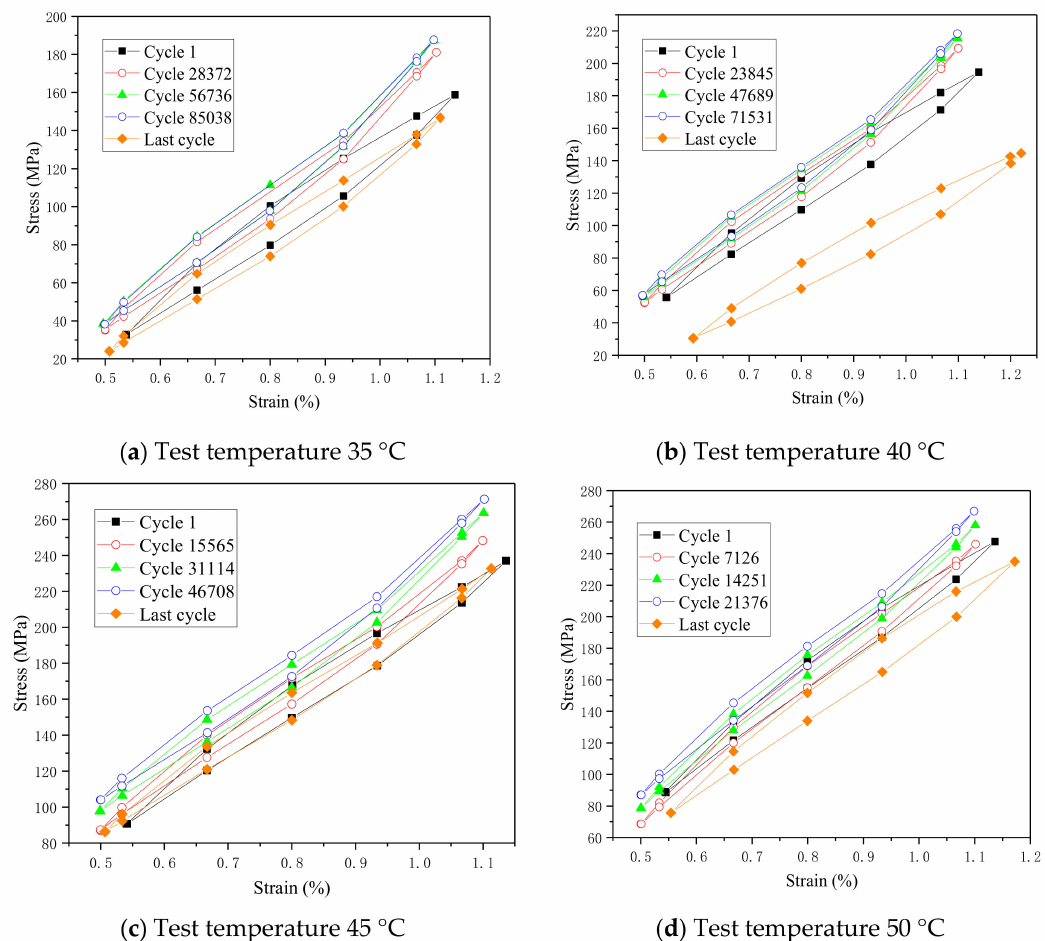
Figure 4. Hysteretic curves of di ff erent test temperatures: ( a ) 35 ◦ C, ( b ) 40 ◦ C, ( c ) 45 ◦ C, and ( d ) 50 ◦